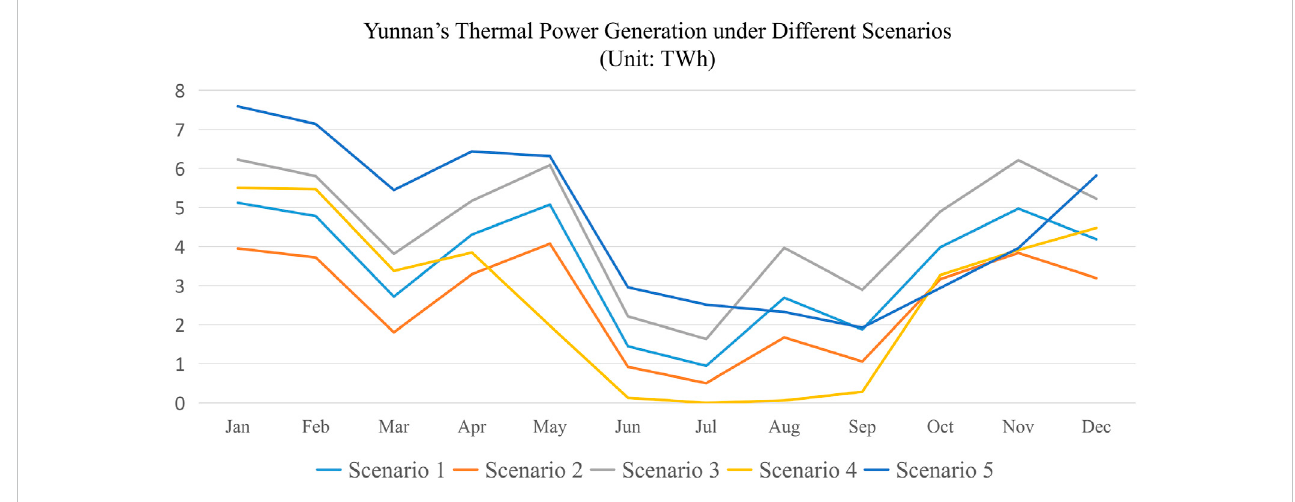
FIGURE 11 Yunnan ’ s thermal power generation under different scenarios.